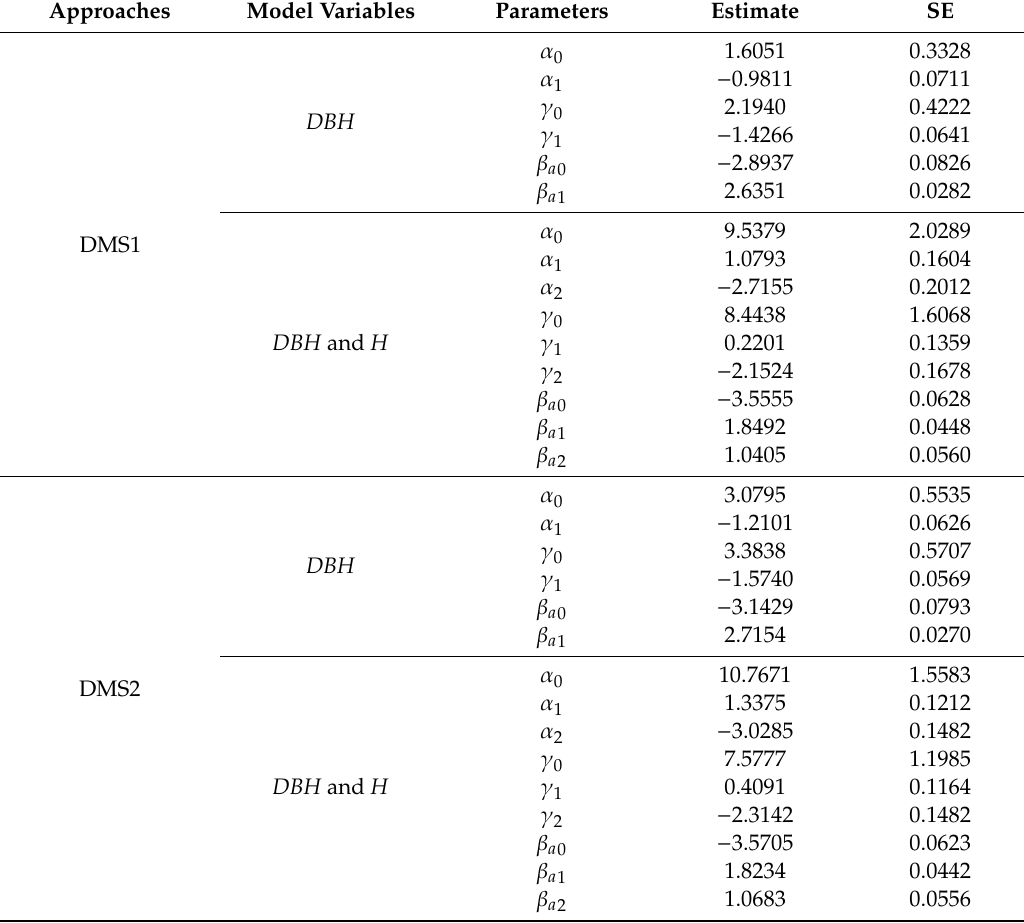
Table 4. Parameter estimates and their standard errors (SE) for the DMS1 [Equations (9) and (10)] and DMS2 [Equations (11) and